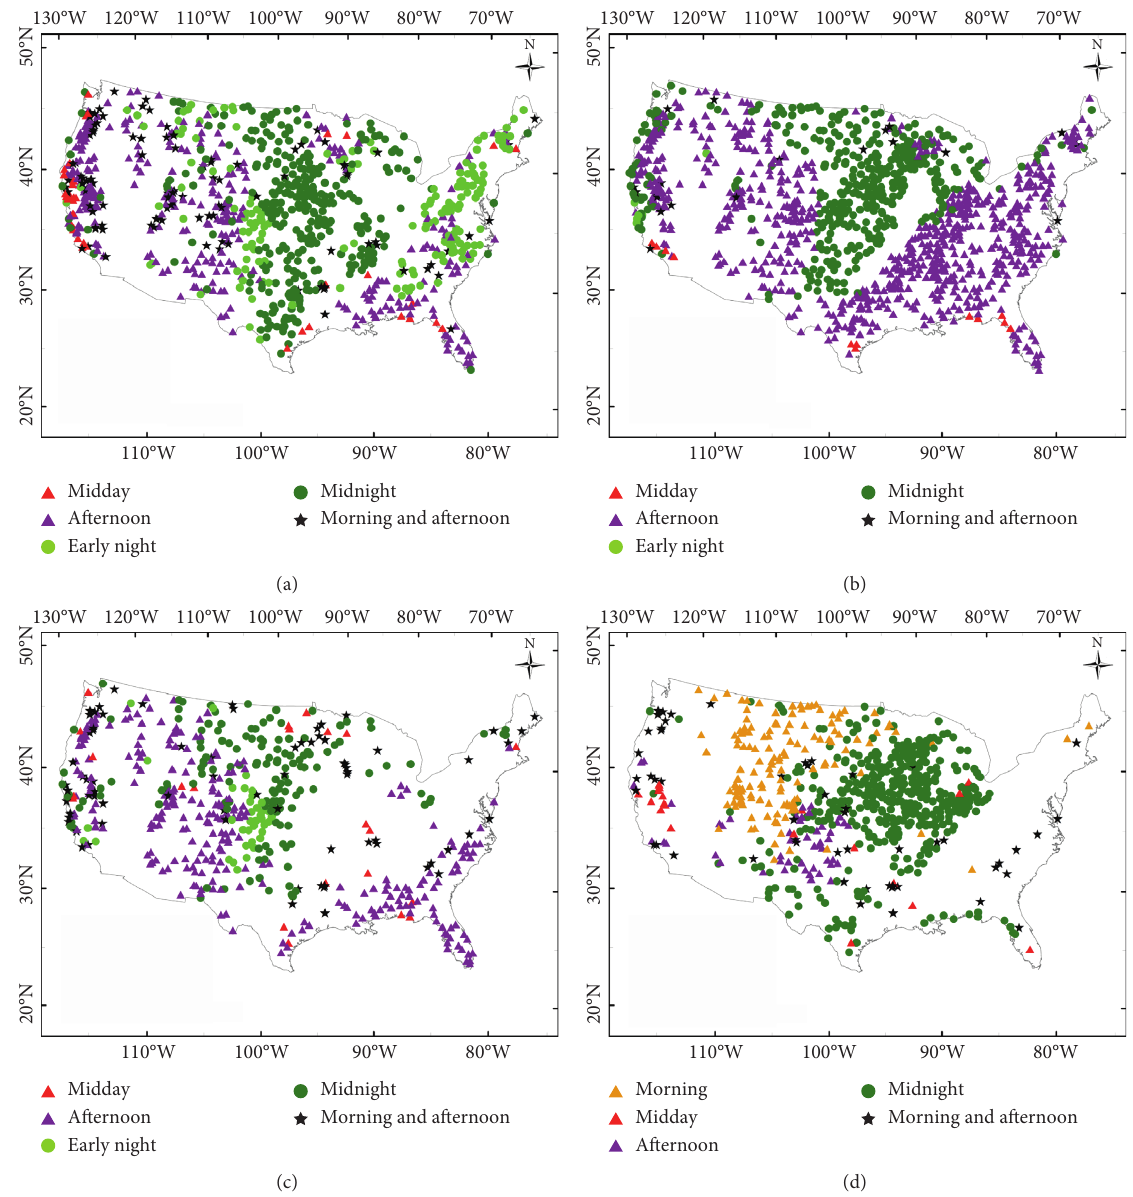
Figure 4: Stations with different diurnal variation of precipitation of TRMM data in different seasons: (a) for spring, (b) for summer, (c) for autumn, and (d) for winter. The triangle represents the diurnal variation with day peak, and the circle represents the diurnal variation with night